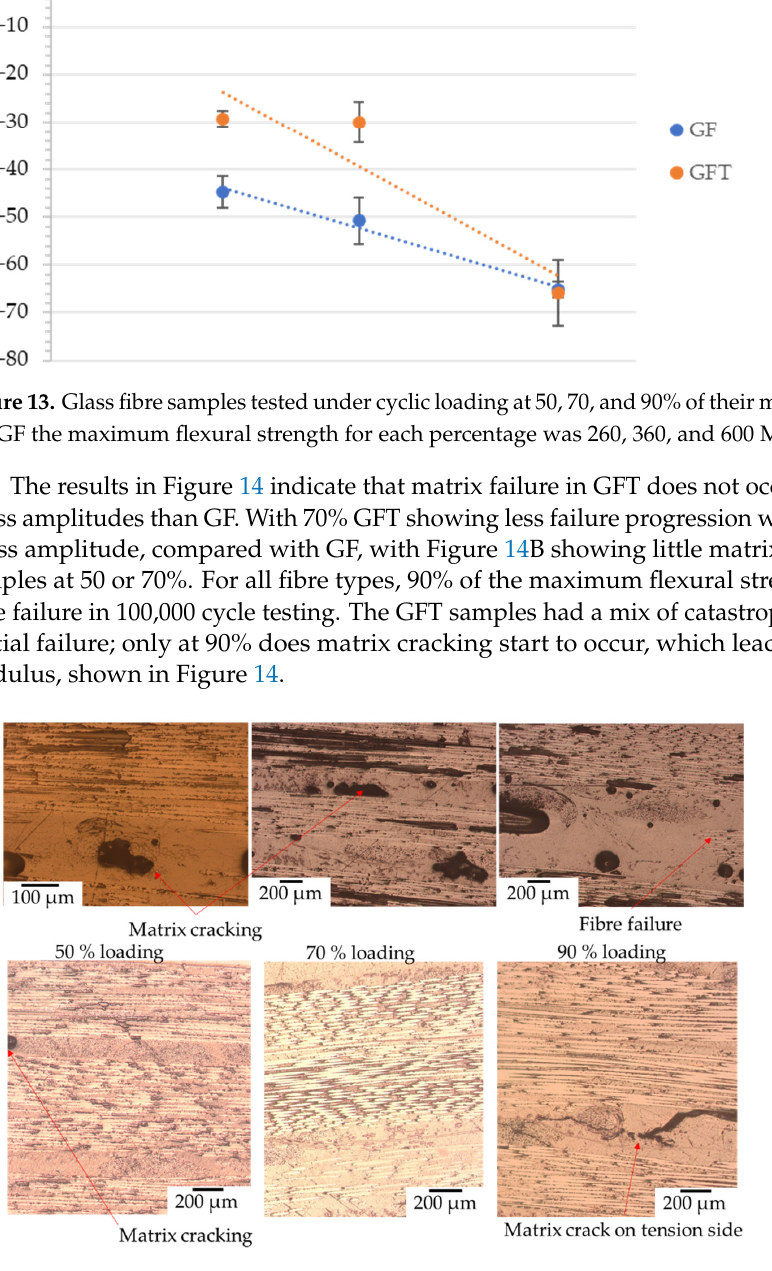
Figure 14. ( A ) GF and ( B ) GFT fibre failure evaluation from loading